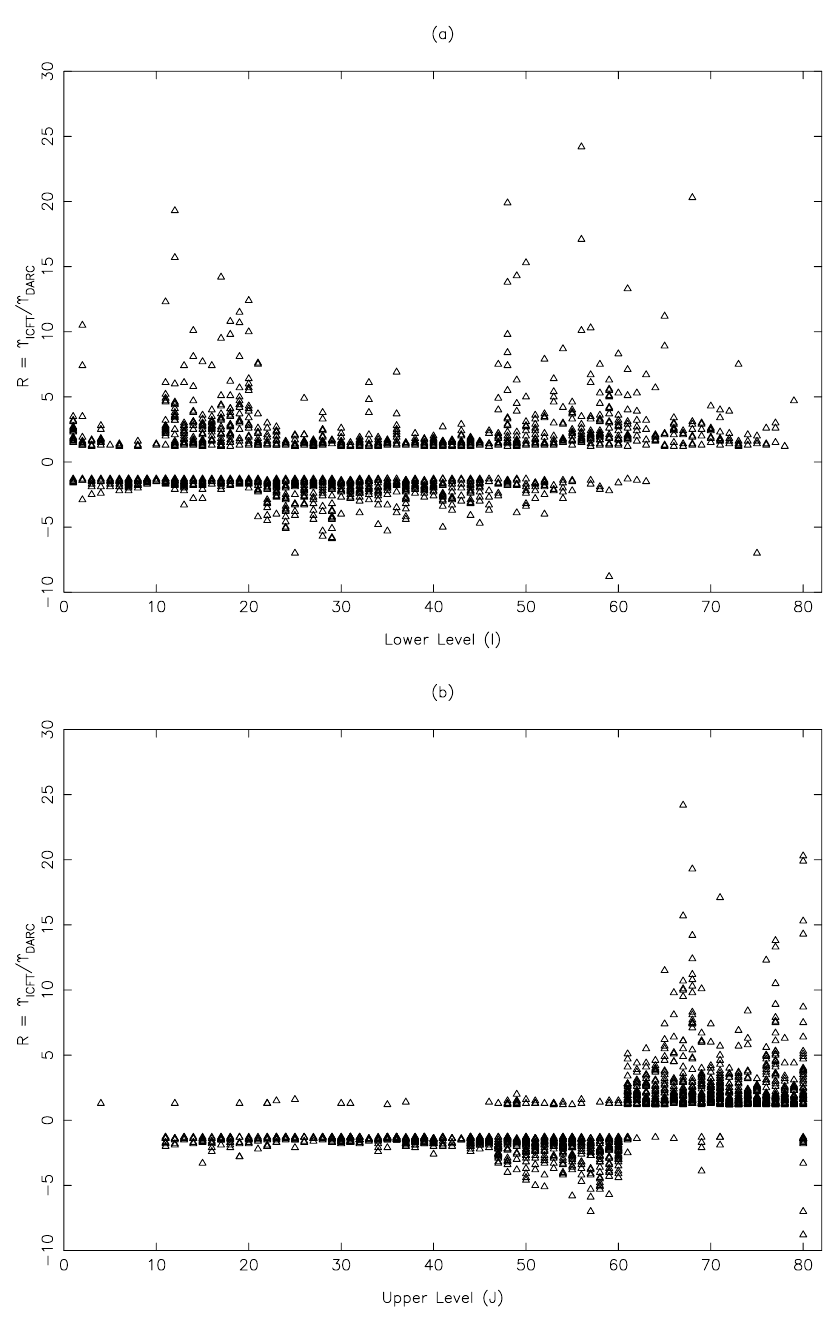
Figure 1. Comparison of Dirac atomic R-matrix code (DARC) [60] and intermediate coupling frame transformation (ICFT) [26] values of Υ for transitions of Al X at T e = 1.0 × 10 6 K. Negative R values plot Υ DARC / Υ ICFT and indicate that Υ DARC > Υ ICFT . Only those transitions are shown that differ by over 20%. ( a ) Transitions from lower and ( b ) to upper